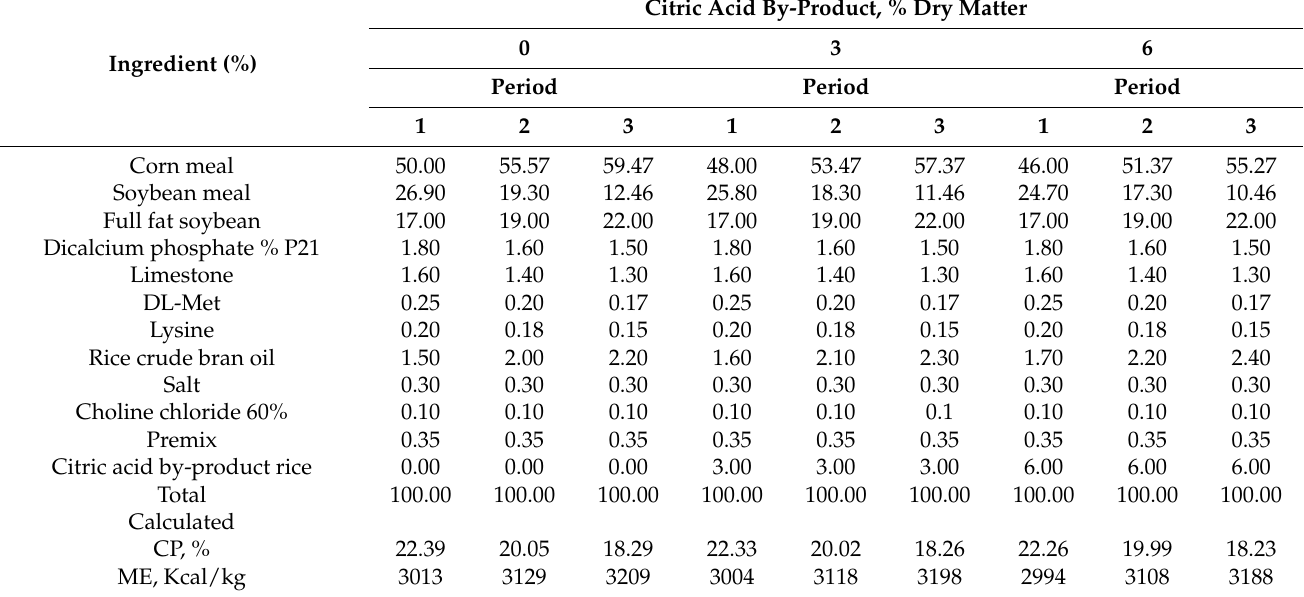
Table 1. Feed ingredient of experimental diet period